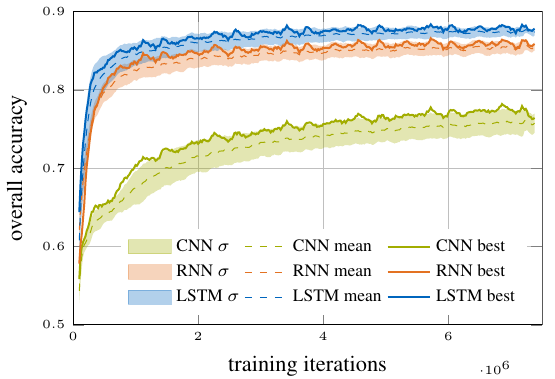
Figure 7. Evolution of overall validation accuracy performance during the training process of 135 networks of each CNN, RNN, and LSTM architecture with different hyperparameter settings. Means (dashed lines) and standard deviation intervals (shaded areas) indicate the general performance of each architecture, the most performand network is superimposed separately (solid